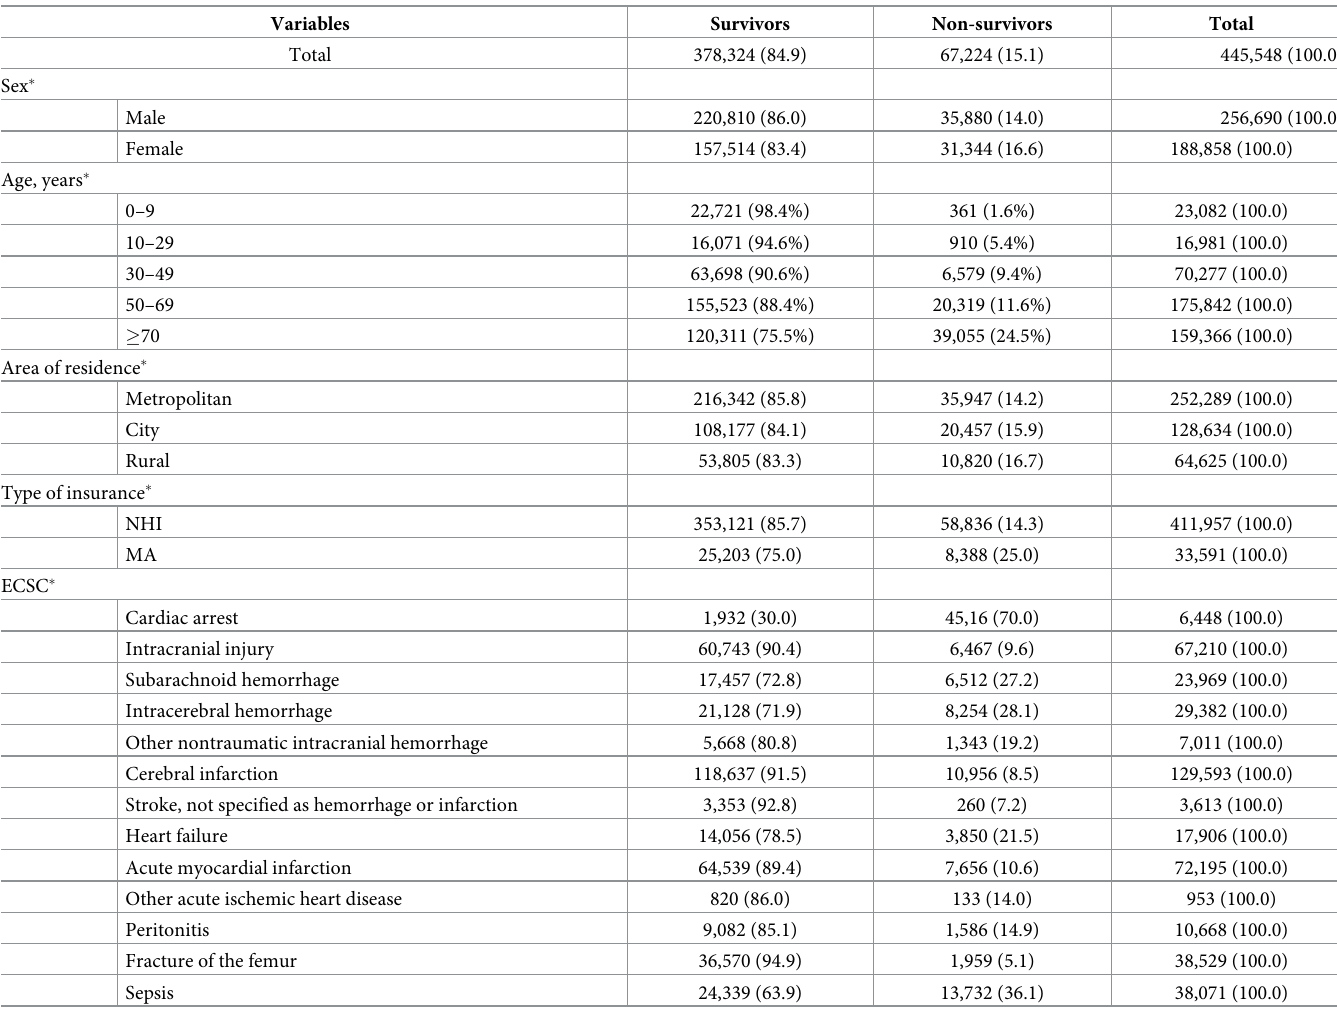
Table 2. Patient